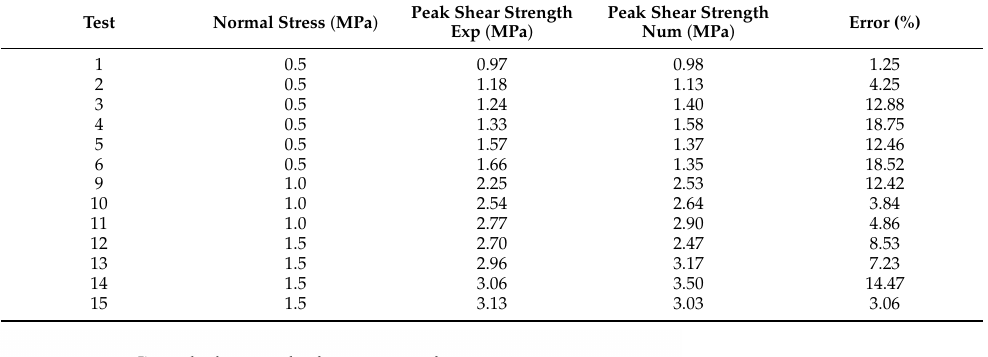
Table 7. Peak shear strength Exp-Num.